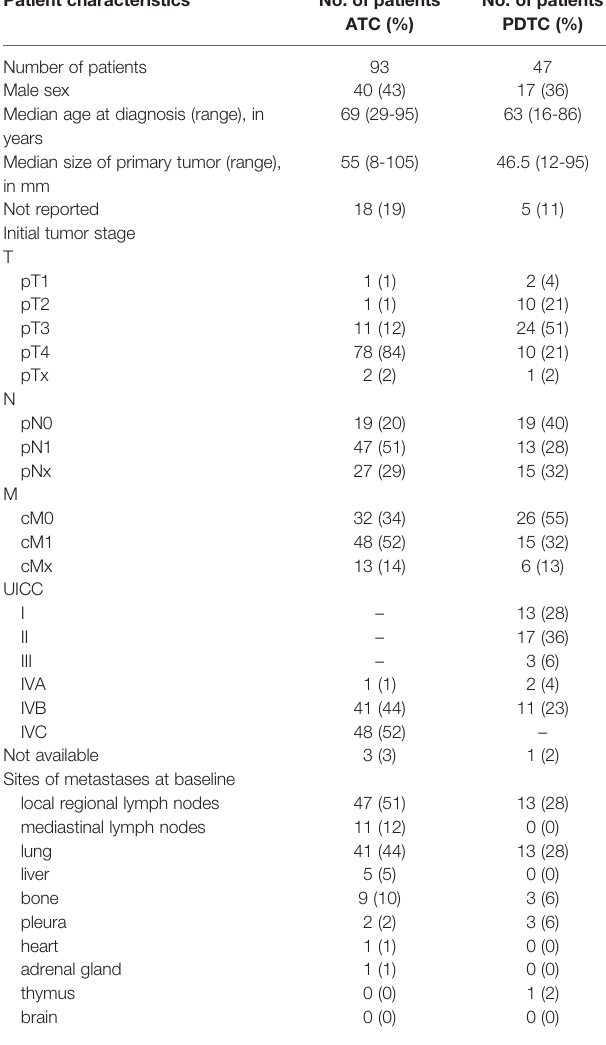
TABLE 1 | Patient characteristics of the study